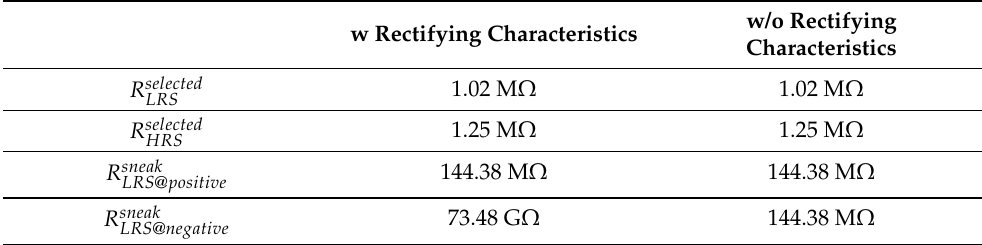
Table 1. Defined parameters in various cases.